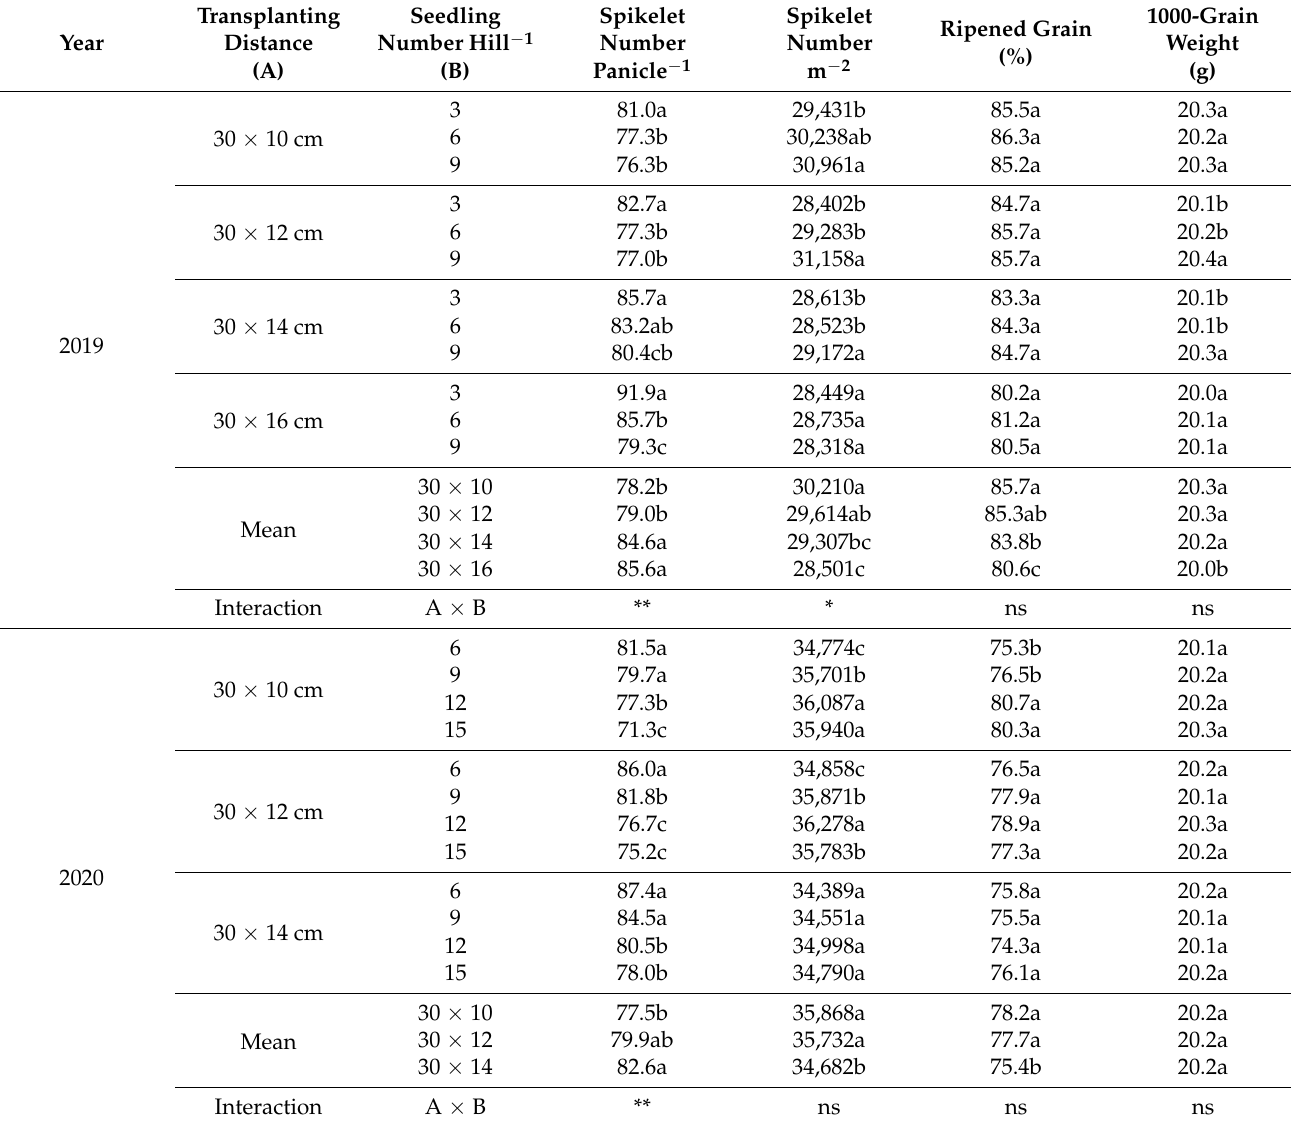
Table 2. The changes in rice-grain-related traits according to transplanting